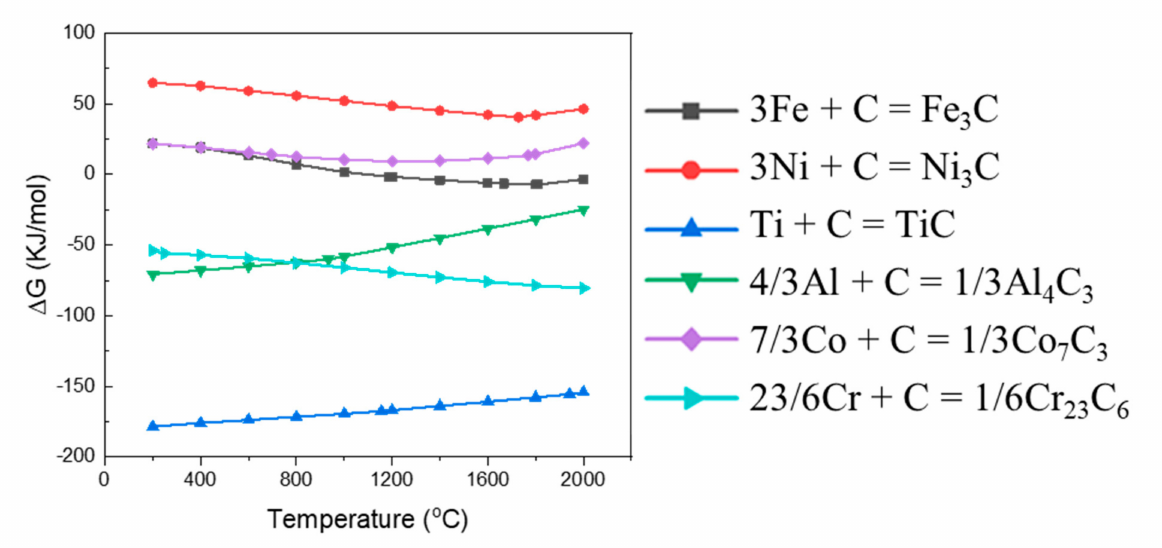
Figure 2. Gibbs free energy for formation of carbide formation reaction between 1 mole of carbon and the metal component in HEAs